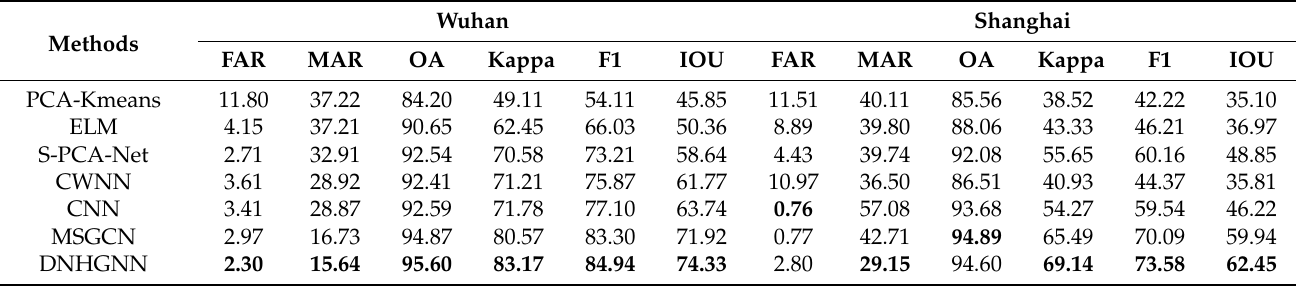
Table 2. Quantitative accuracy results for different methods on the SAR data sets (%).